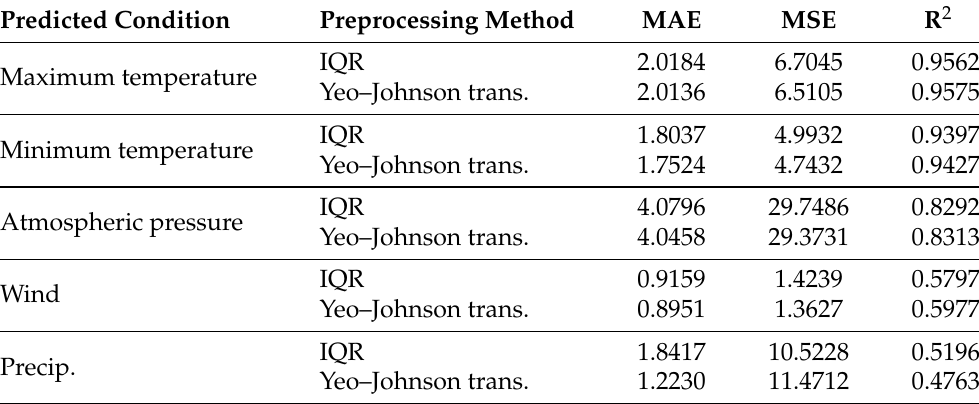
Table 4. Comparison of the weather condition prediction accuracy using the Yeo–Johnson transfor- mation and IQR in data